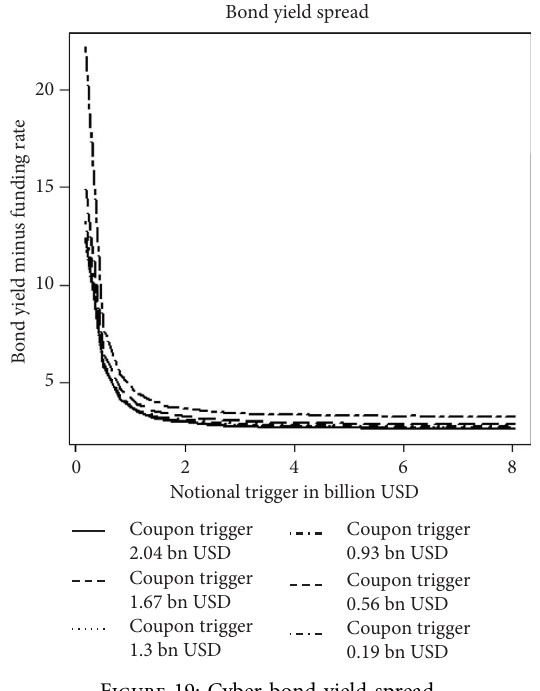
Figure 19: Cyber bond yield spread.